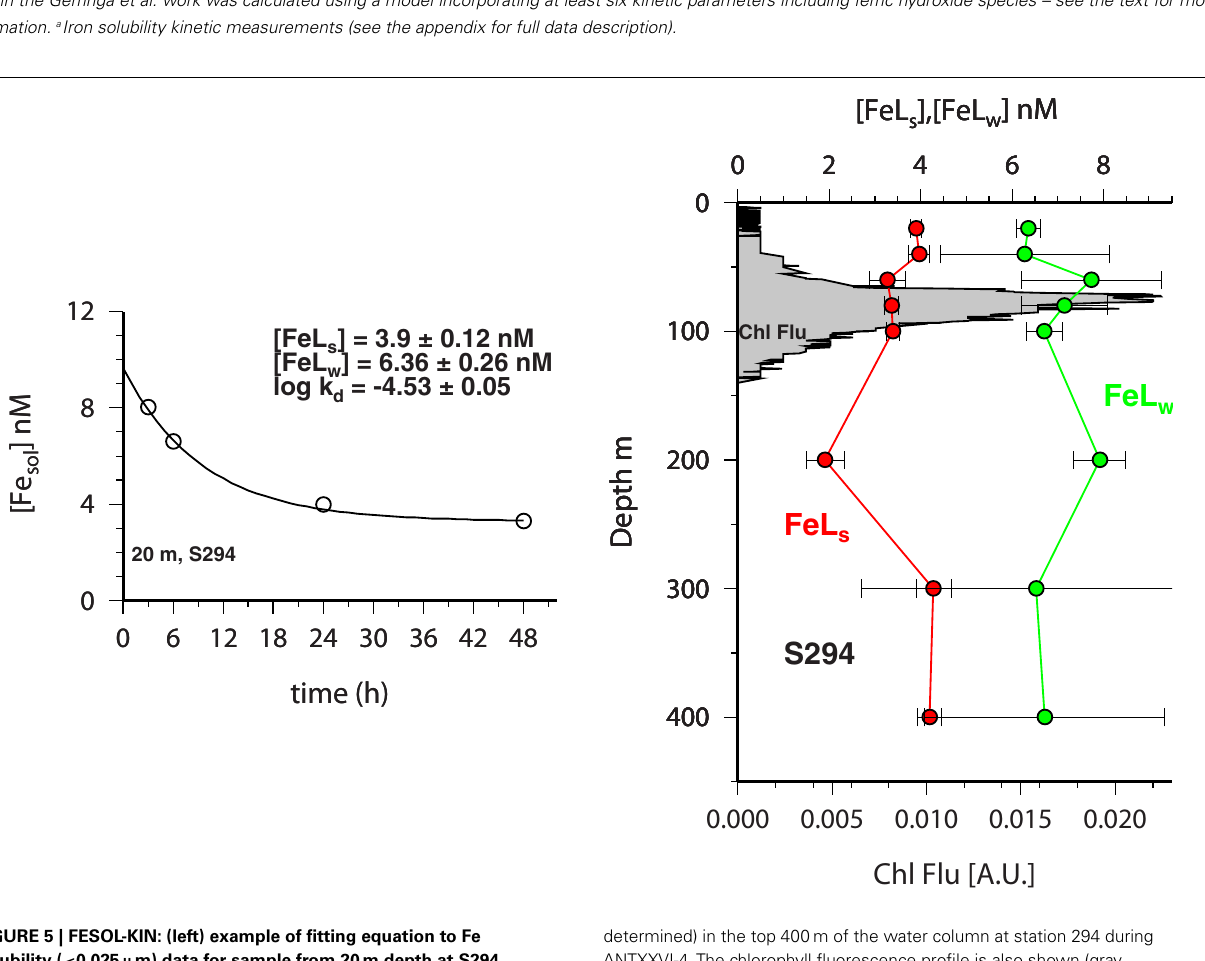
determined) in the top 400m of the water column at station 294 during ANTXXVI-4.The chlorophyll fluorescence profile is also shown (gray shading;